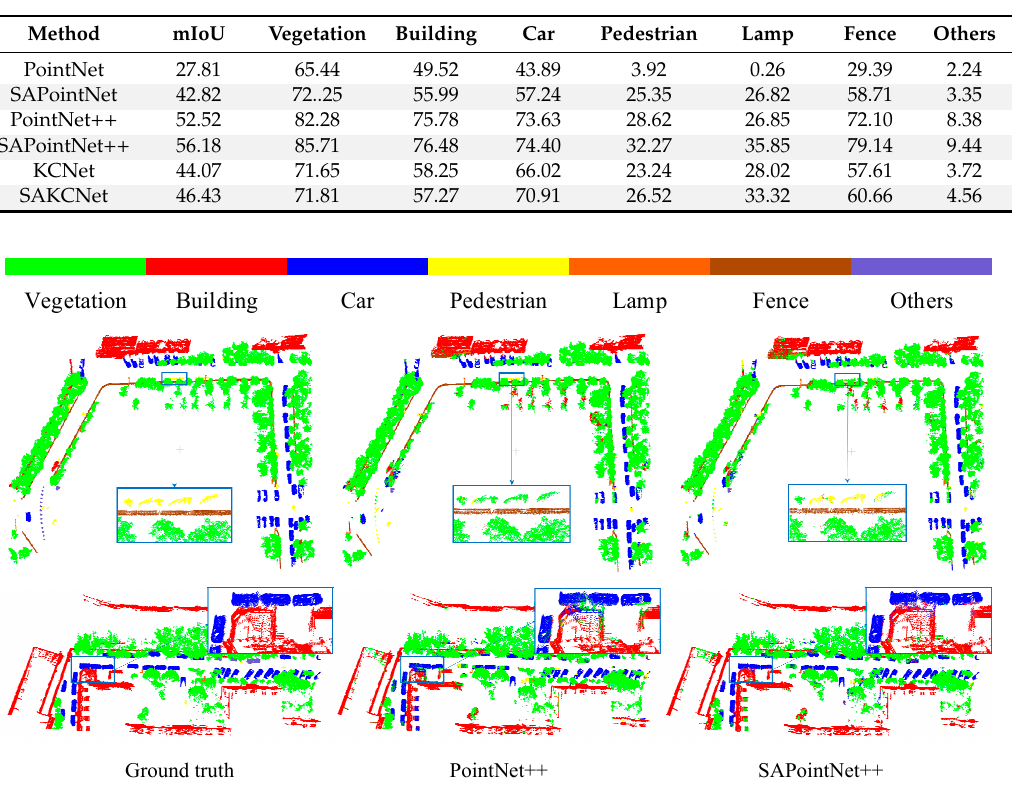
Table 3. Semantic segmentation IoU (%) on the WHU MLS point cloud.